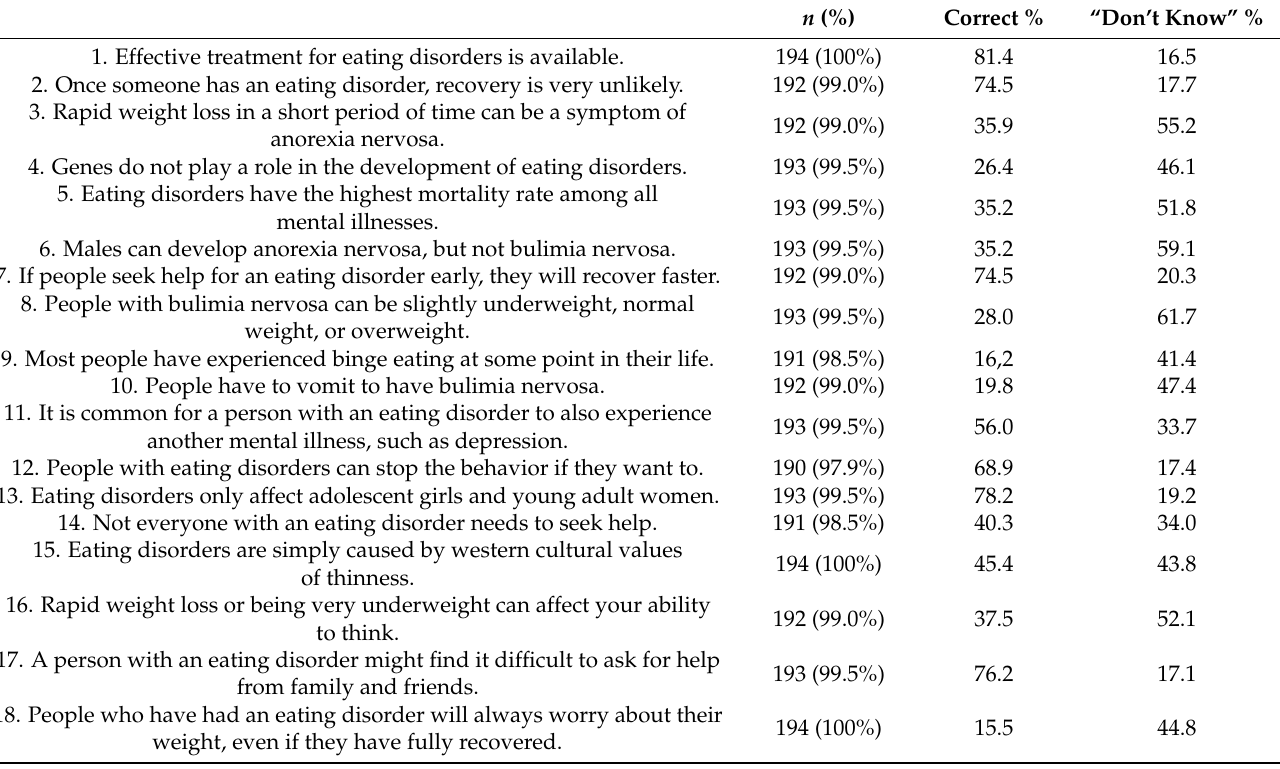
Table 3. Text and percentages of correct and “don’t know” answers for the 18 ED-MHL statements. n (%) Correct % “Don’t Know”